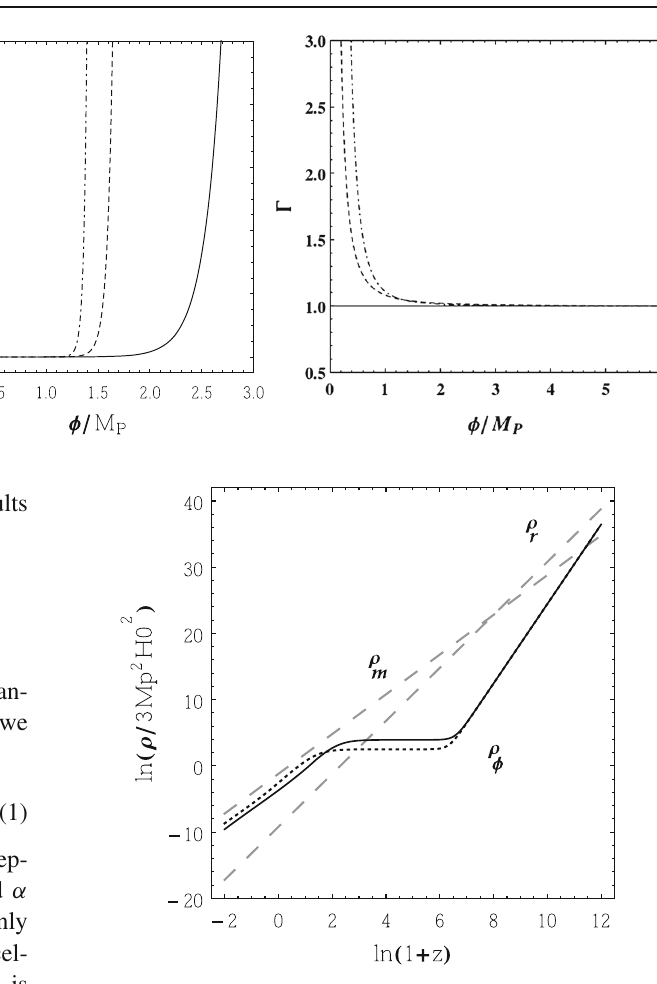
Fig. 2 This figure exhibits the evolution of energy densities of field and background (matter and radiation; dashed lines) versus redshift. The field energy density is obtained for the potential (1) with n = 1 and α = 4 (dotted), 6 (solid line). In this case, field energy density scales with the background. Hence, we never get late-time acceleration